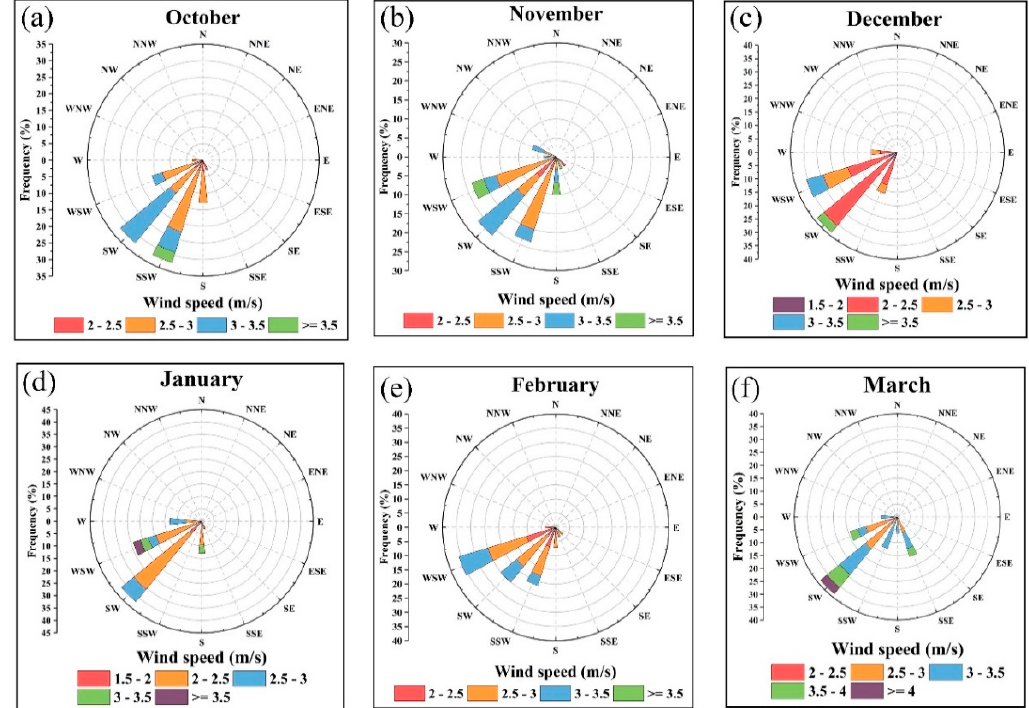
Figure 11. The wind rose of the Chagan Lake in different months: ( a ) October ( b ) November; ( c ) December; ( d ) January; ( e ) February; ( f ) March. The wind direction is expressed by 16-degree angle, including north (N), north northeast (NNE), northeast (NE), east northeast (ENE), east (E), east southeast (ESE), southeast (SE), south southeast (SSE), south(S), south southwest (SSW), southwest (SW), west southwest (WSW), west (W), west northwest (WNW), northwest (NW), north northwest (NNW) .